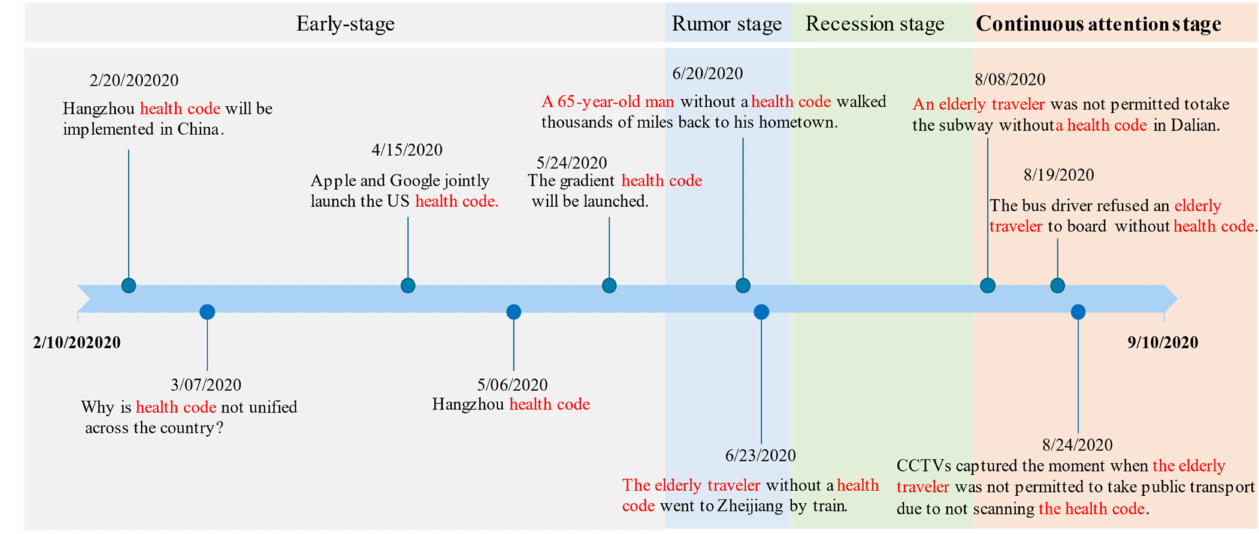
Figure 6. Trending hashtags on health code on Weibo from 10 February 2020 to 10 September